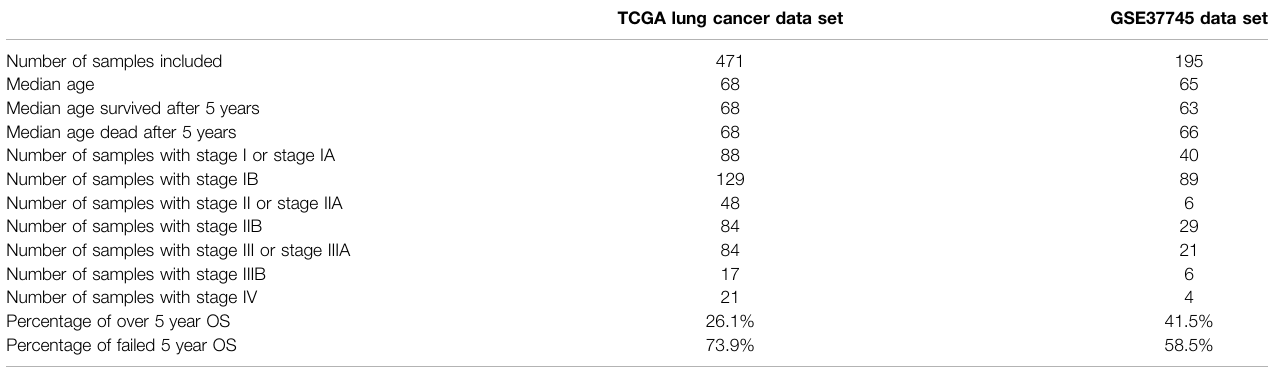
TABLE 1 | The general statistic for the datasets analyzed. Stages I to IV are the tumor stages de fi ned by the AJCC staging system (Edge and Compton,